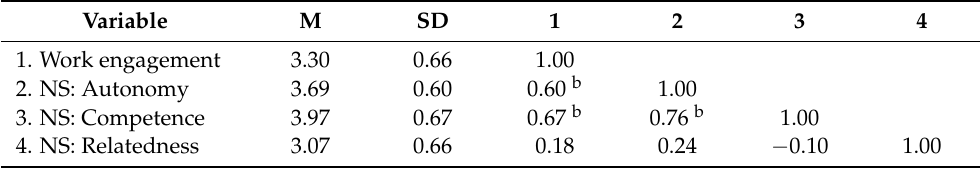
Table 2. Descriptive statistics and correlation matrix for the day-level